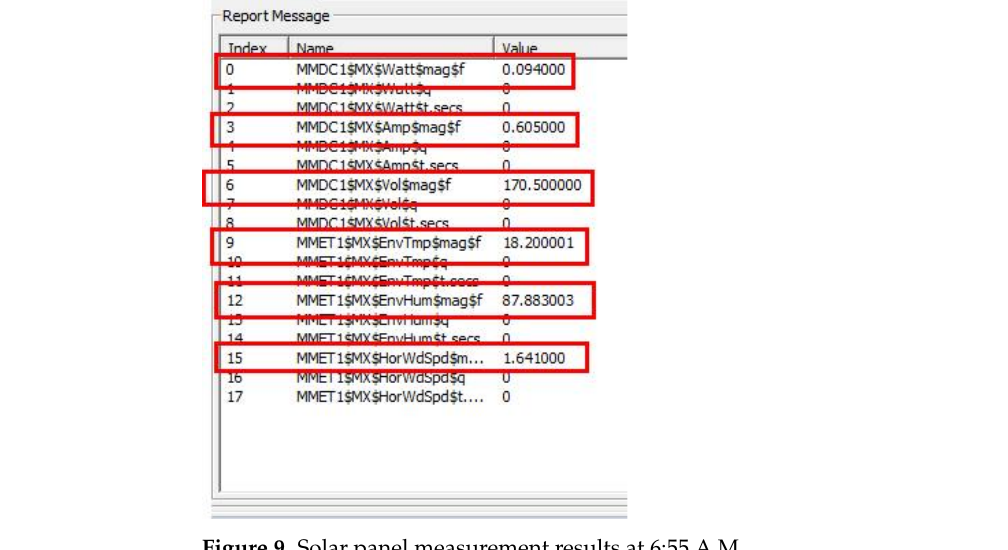
Figure 9. Solar panel measurement results at 6:55 A.M. During the daytime, the generated power by the solar panel increases, as shown in Figure 10. The Report message shows the generated power of 208 W, 1.364 A of the current, 192.944 V of the voltage, 27.6 °C of the temperature, 59.4% of the humidity, and 3.873 mph of the wind speed.